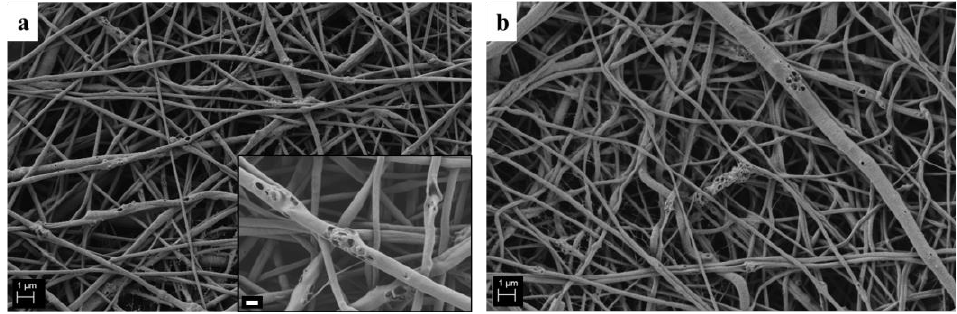
Figure 9. SEM micrograph of PCL_Ca_MCM-41 electrospun mats after 1 day ( a ) and 7 days ( b ) of immersion in SBF solution. Scale bar 1 μ m and for the inset scale bar 200 nm.